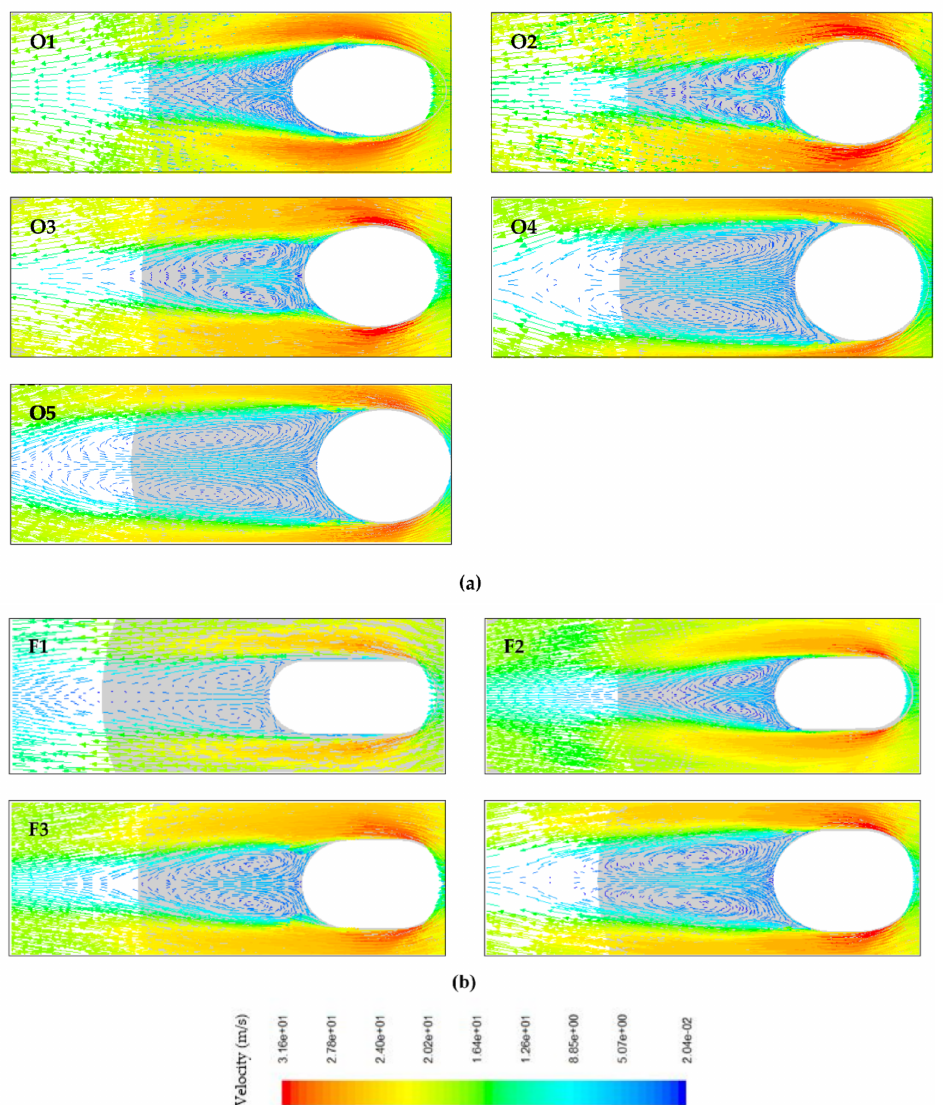
Figure 5. Velocity vectors representing wake region formation behind the second row for: ( a ) oval and ( b ) flat